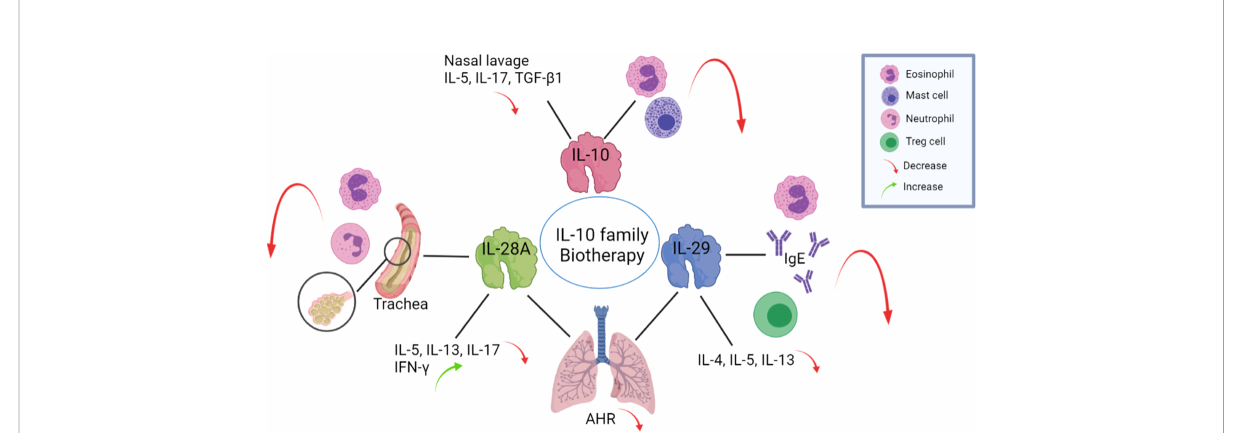
FIGURE 3 The application of IL-10 family members may exert bene fi cial effects on airway in fl ammatory diseases. Exogenous IL-10 administration reduces the in fi ltration of eosinophils and mast cells in the nasal mucosa and reduces IL-5, IL-17, and TGF- b 1 levels in nasal lavage fl uid. Intranasal administration of IL-28A to OVA-challenged mice suppresses the number of eosinophils and neutrophils in the BALF and reduces IL-5, IL-13 and IL-17 levels but increases IFN- g level in lung-draining mediastinal lymph nodes. The administration of IL-29 to an OVA mouse model decreased eosinophil count, serum IgE level, induction of Tregs production and the expression levels of the Th2 cytokines IL-4, IL-5, and IL-13. Both IL-28A and IL-29 reduce AHR levels. BALF: bronchoalveolar lavage fl uid, AHR: airway hyperresponsiveness, OVA: